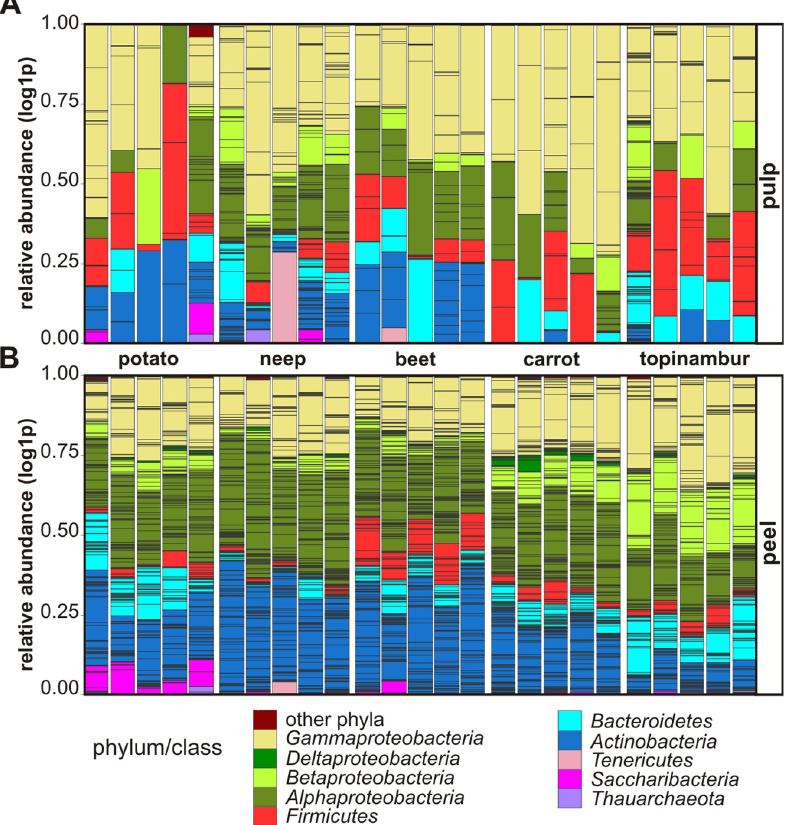
Fig 3. Log-transformed relative abundances of bacterial phyla found in five root vegetables. All OTUs defined in the current study are indicated on the bar based on a phylum/class color code. Proteobacteria are shown at the class level, other bacteria at the phylum level. Pulp (A) and peel (B) are